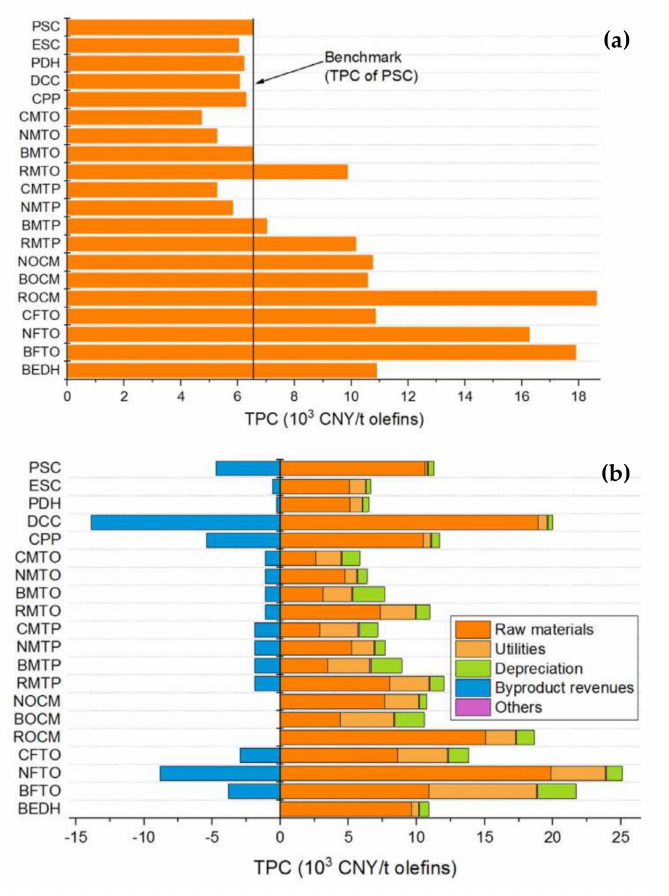
Figure 2. ( a ) Total production costs of different olefin production technologies, ( b ) a detailed break- down of the TPCs of different production pathways